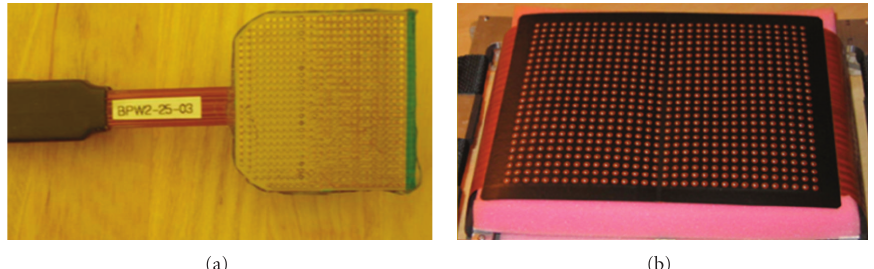
Figure 2: Tactile sensory substitution electrotactile displays used by Mina. (a) Wicab BrainPort 600 pixel tongue array; (b) a 768 titanium electrode abdominal array (ForeThought VideoTact).